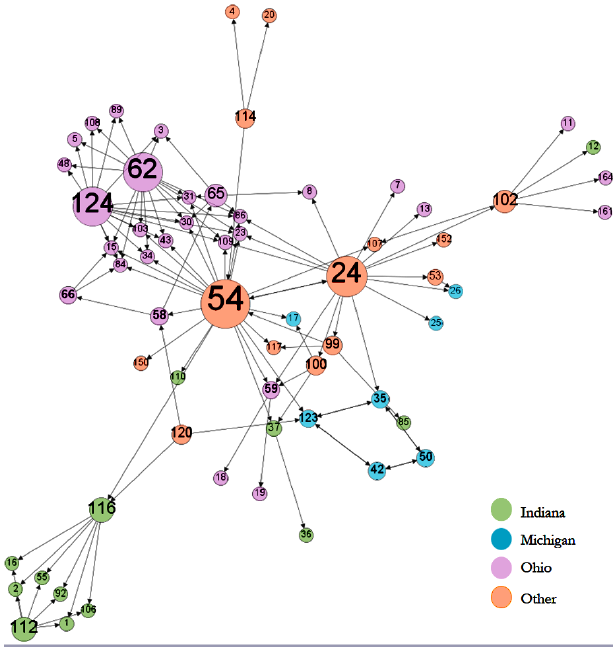
Fig. 2 . Coordination network in the Maumee River